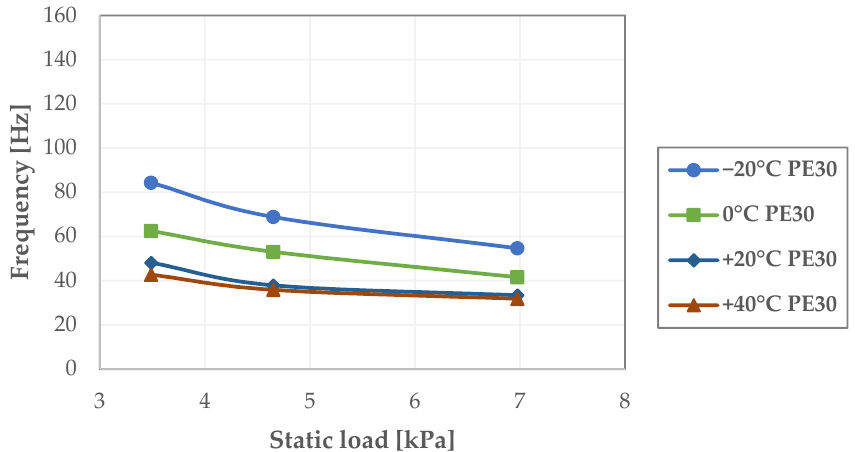
Figure 11. Resonant frequencies of PE30 as a function of temperature.